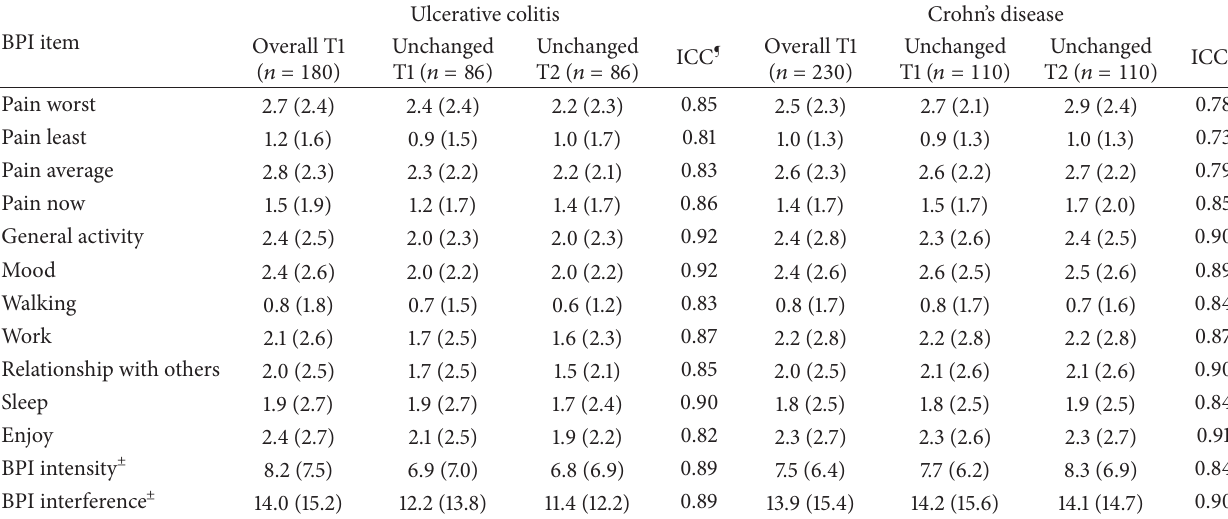
Table 2: Overall mean (SD) BPI scores according to diagnosis and test-retest scores in patients with an unchanged